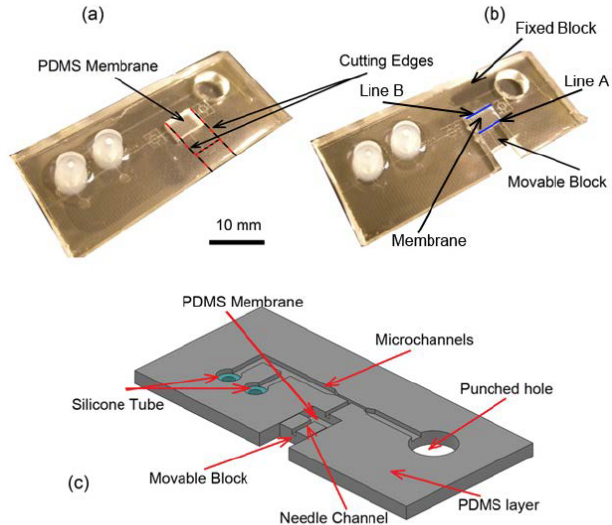
Figure 7. Steps and schematic of PDMS chip cutting and pouching ( a ) The PDMS chip after trimming and pouching. ( b ) The PDMS chip after cutting and releasing the movable block. ( c ) Schematic of different parts of the PDMS chip after casting.